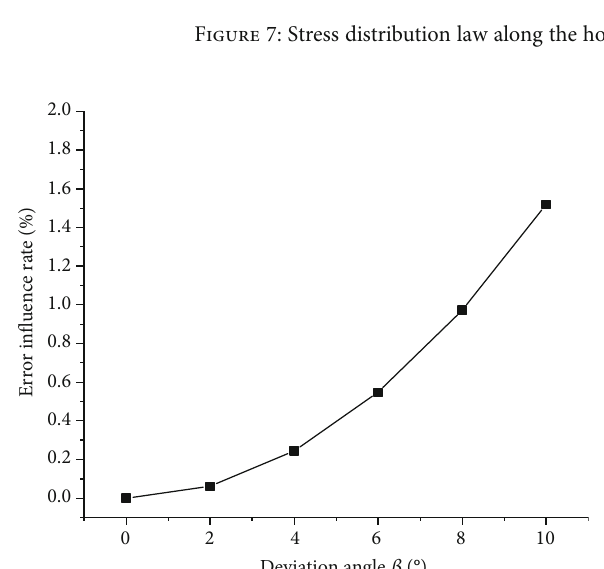
Figure 7: Stress distribution law along the horizontal diameter under di ff erent deviation angles.